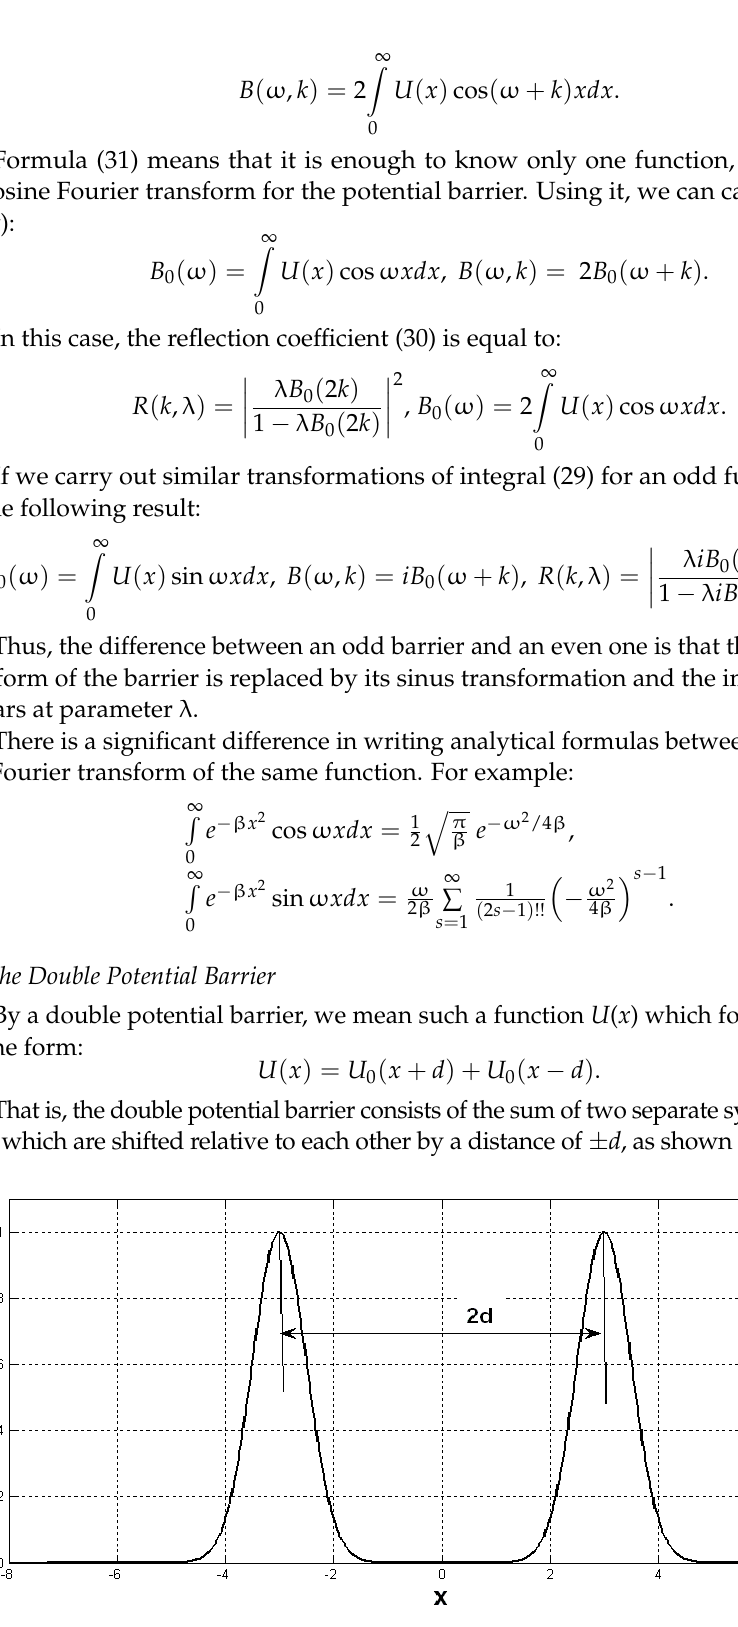
Figure 1. Shape of double potential barrier. It is clear that, in this case, the value B ( ω , k , d ) depends, apart from the parameters ω and k, on the distance d between the